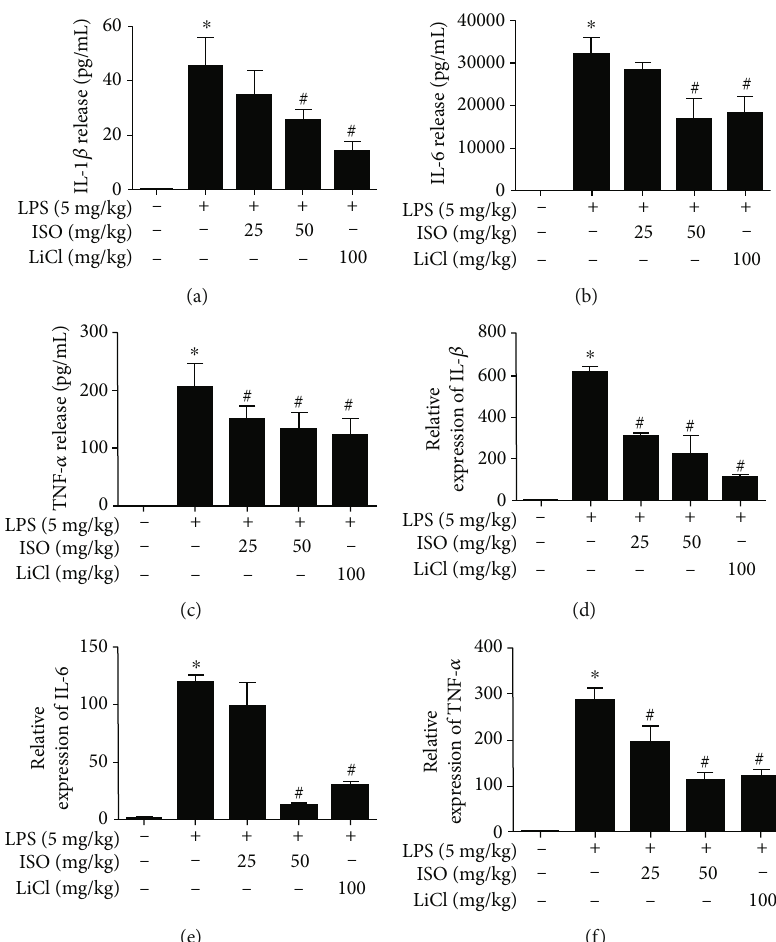
Figure 4: Isoorientin inhibited proin fl ammatory cytokines in the sera and cortices of endotoxemia mice. Isoorientin (25 and 50 mg/kg/d, ig) and LiCl (100mg/kg/d, ig) were given once a day for 5 days, and after 30min of the last administration, LPS (5 mg/kg, ip) was injected. The blood and tissues were collected after 6 h of LPS injection. IL-1 β (a), IL-6 (b), and TNF- α (c) in the sera were detected by ELISA ( n = 6 , 6 biological replicates). IL-1 β (d), IL-6 (e), and TNF- α (f) in the cortices were detected by qPCR ( n = 3 , 3 biological replicates). The data were expressed as mean ± SEM . Statistical analysis was done using ANOVA. ∗ P < 0 : 05 versus the control group. # P < 0 : 05 versus the LPS